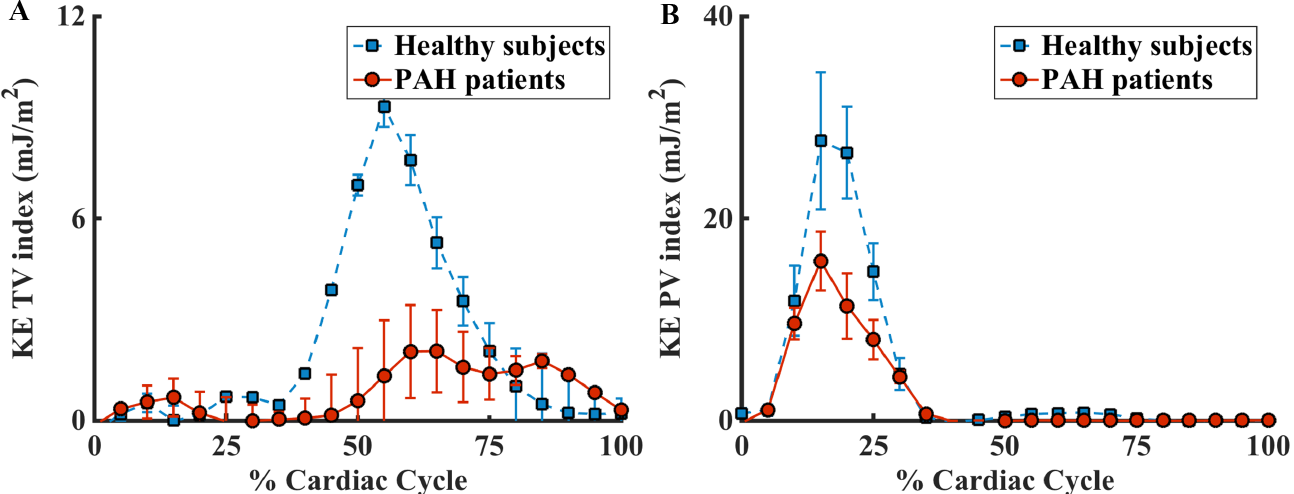
Fig 2. Comparison of the in flow kinetic energy and outflow kinetic energy in healthy subjects and PAH subjects. (A). Normalized KE in through the tricupsid valve. (B). Normalized KE out through the pulmonic valve.